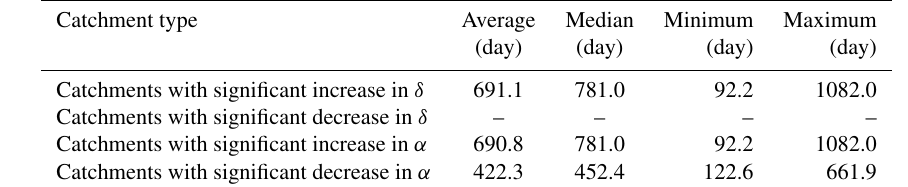
Table 6. Response times of different groups of catchments with significant increase or decrease in regression parameters α and δ .